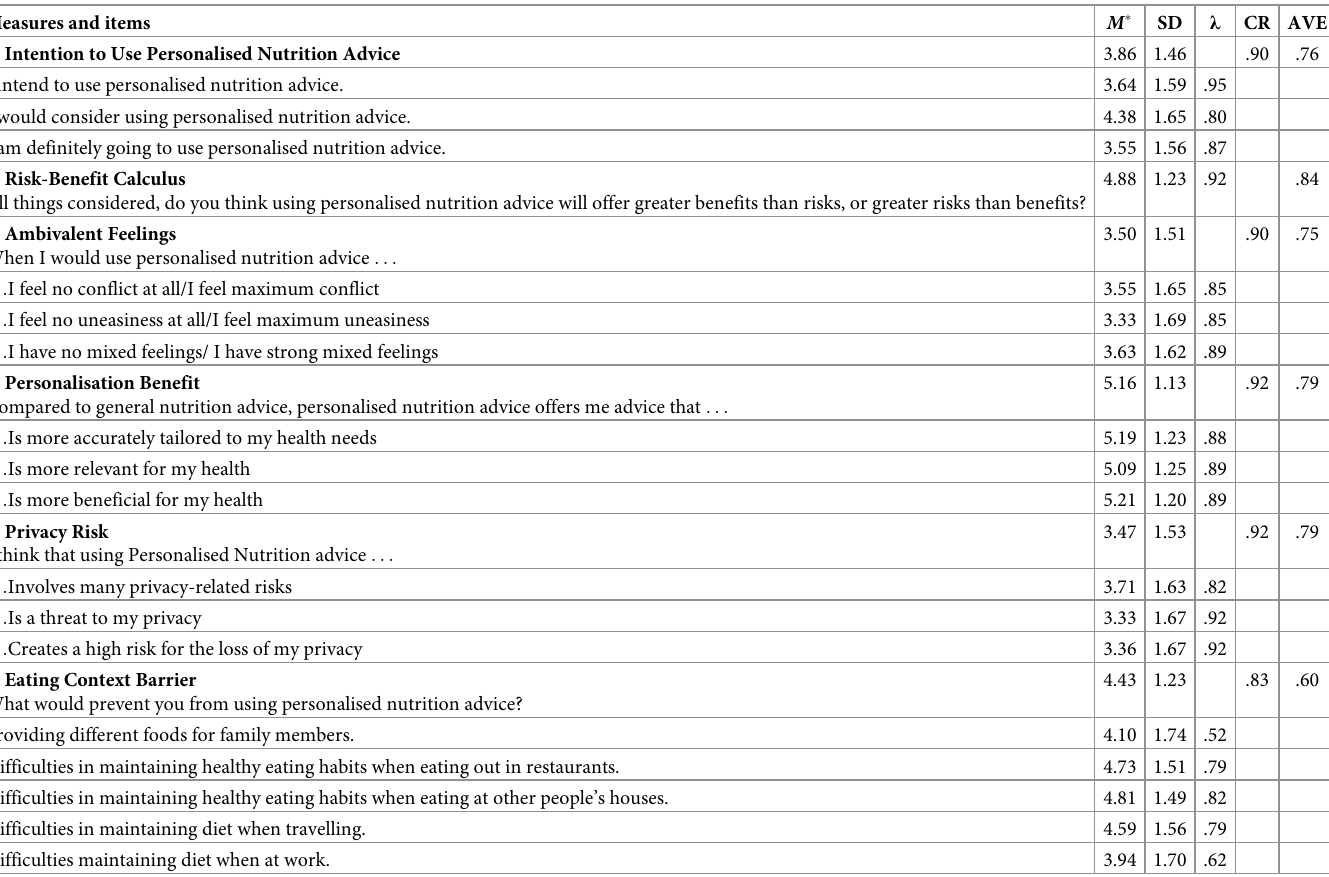
Table 2. Measurement items, means, factor loadings, and reliability and validity checks (N = 797). Measures and